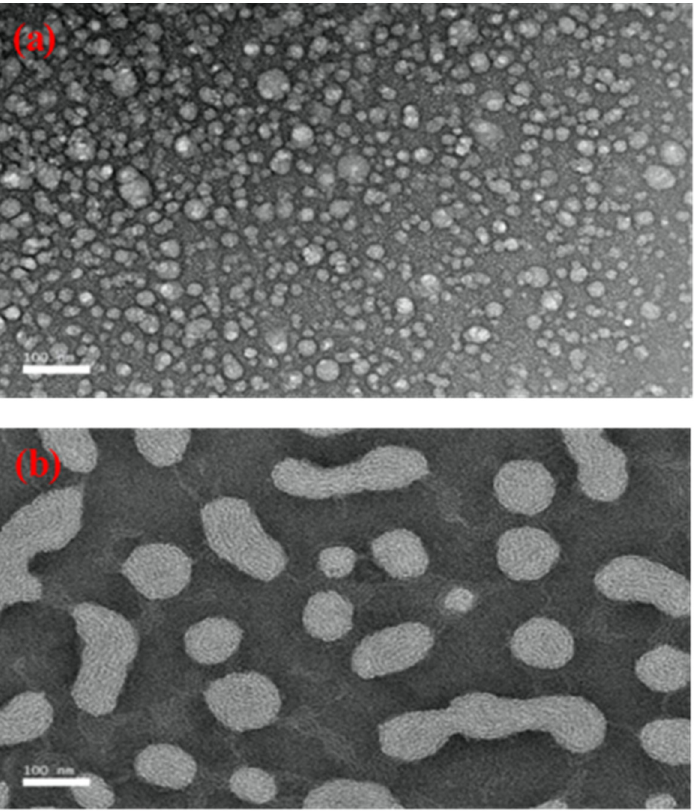
Figure 4. TEM images of SBH NEs without oleic acid ( a ), and with 1% ( w / w ) oleic acid ( b ).